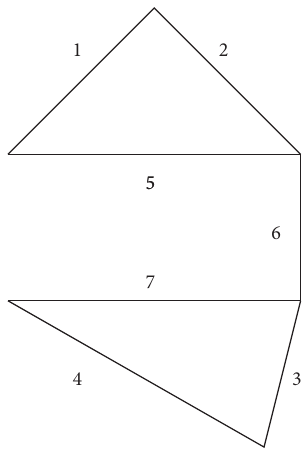
Figure 1: A 2 − cyclic graph with 7